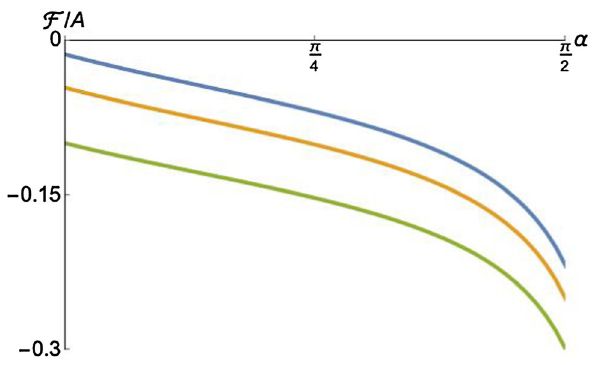
Fig. 9 F / A for U ∈ M ( 0 ) at low temperatures: T = 0 (blue line), F T = 0 . 55 (yellow line), and T = 0 . 75 (green line)